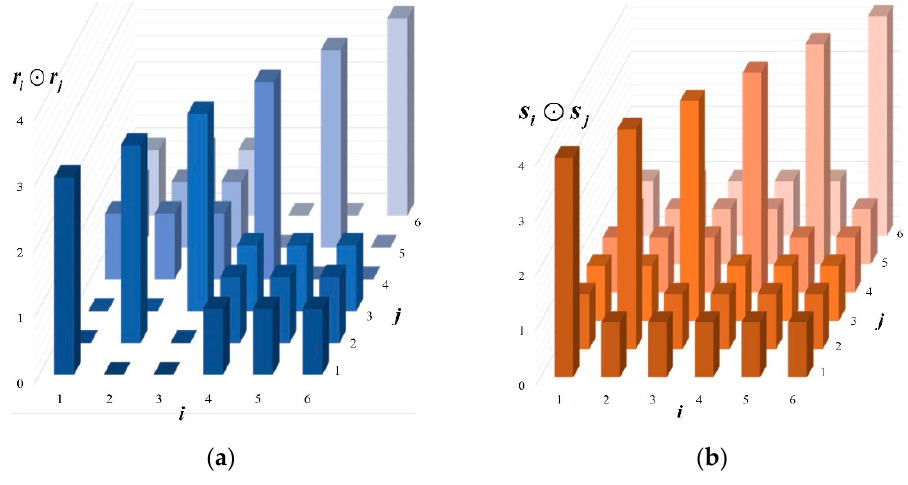
Figure 1. Code correlations of ( a ) RSQC codes and ( b ) SQC codes.